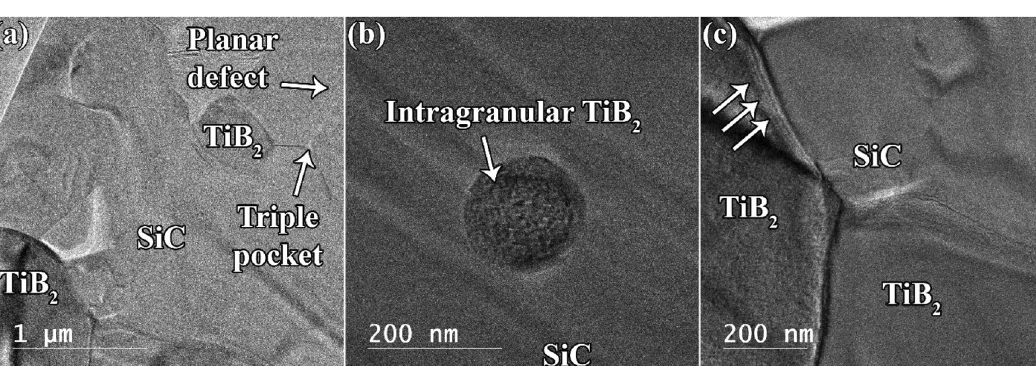
Figure 7. STEM image of the FIB specimen of the C f -incorporated TiB 2 –SiC composite, along with the relevant EDS maps of Ti, B, Si, C, and O elements.